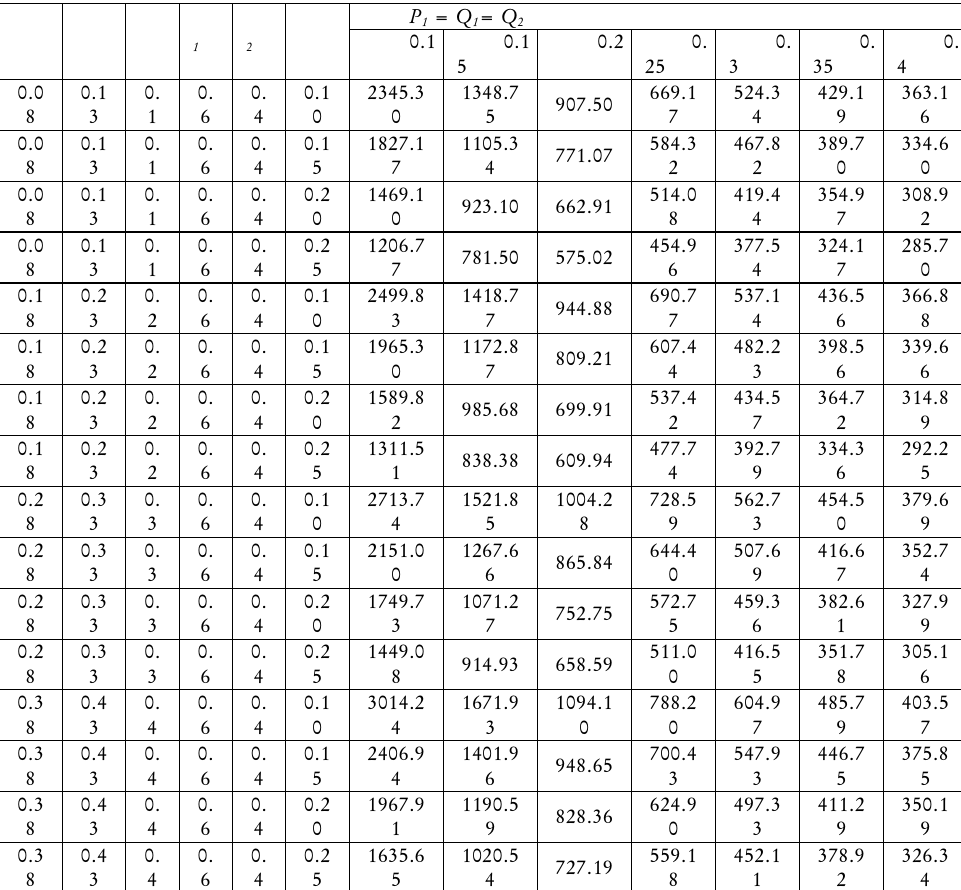
π with respect to Kim and Warde mS π kw